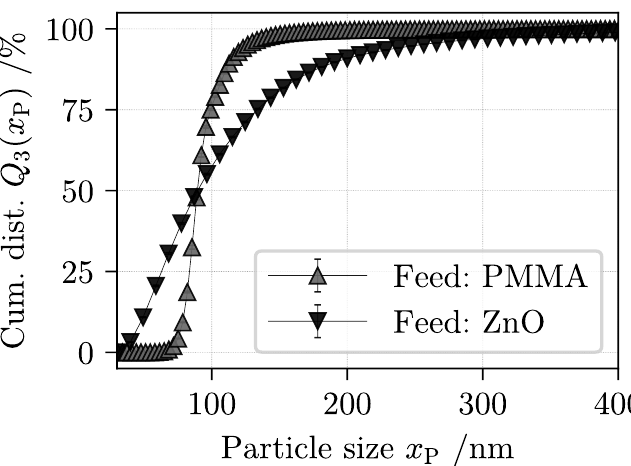
Figure 2. Particle size distribution of single-component suspensions measured with an analytical disk centrifuge.